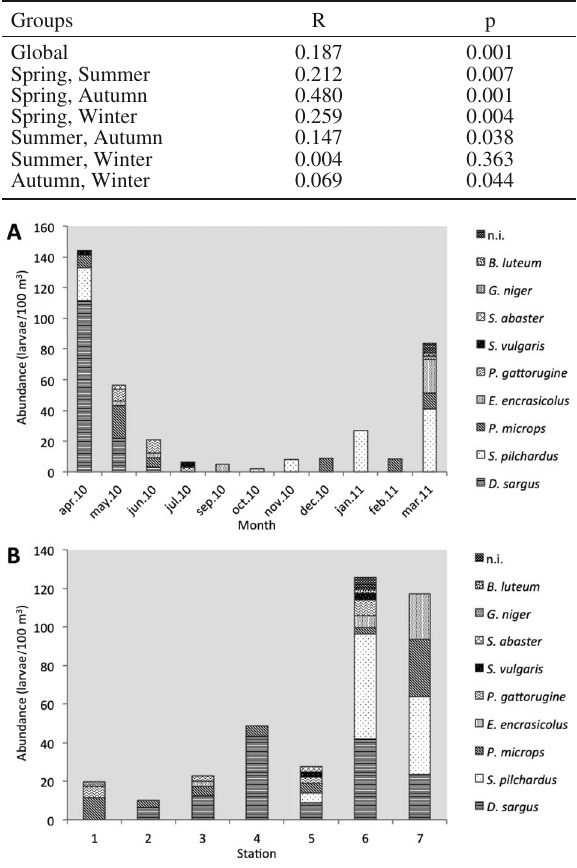
Table 2. – ANOSIM analysis of the factor “Season” determined for the fish larvae captured in the Lezíria salt marsh creek from April 2010 to March 2011.